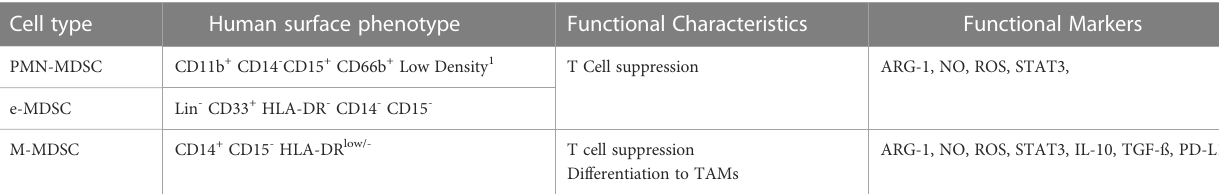
Table 1. Polymorphonuclear (PMN-MDSCs) resemble neutrophils